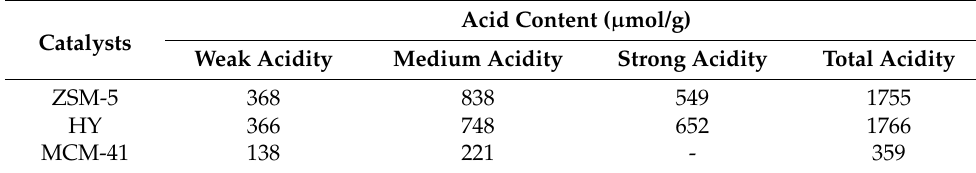
Table 2. Acidity distribution of three kinds of catalysts .